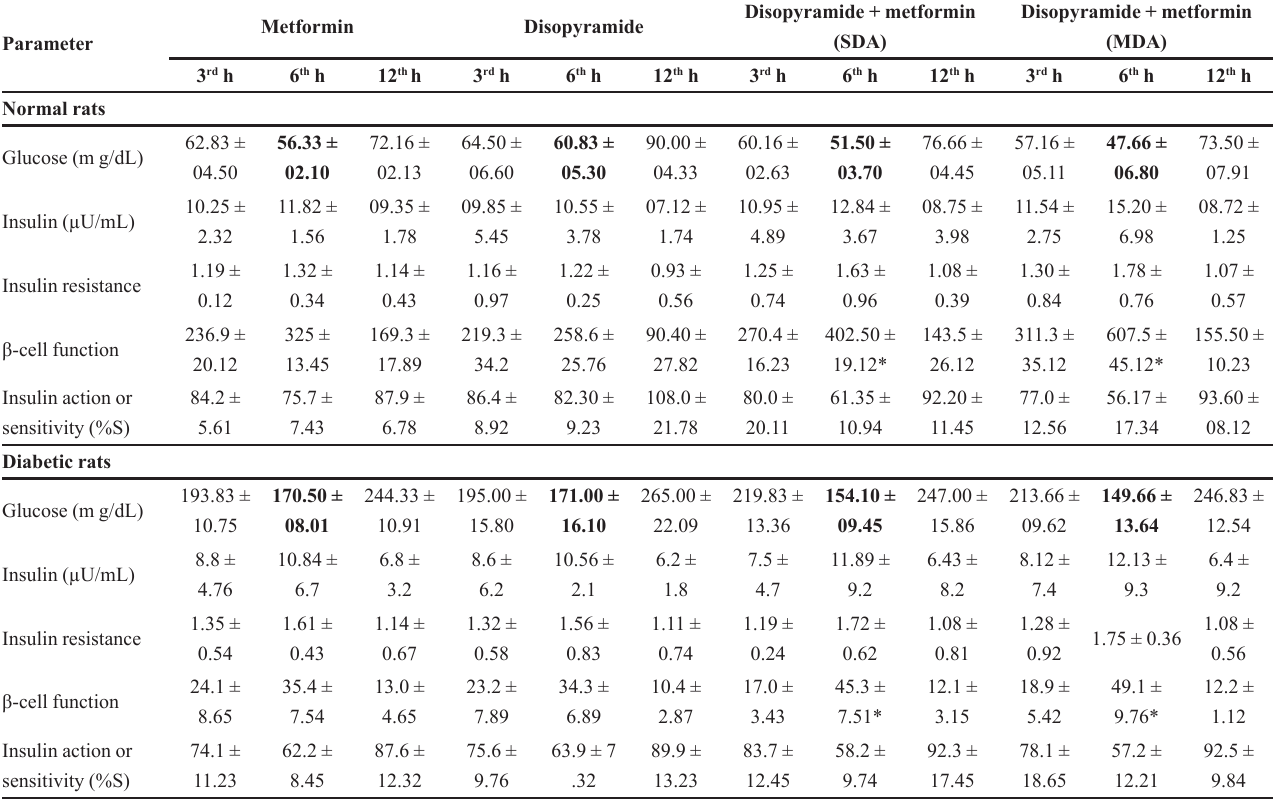
Disopyramide + metformin